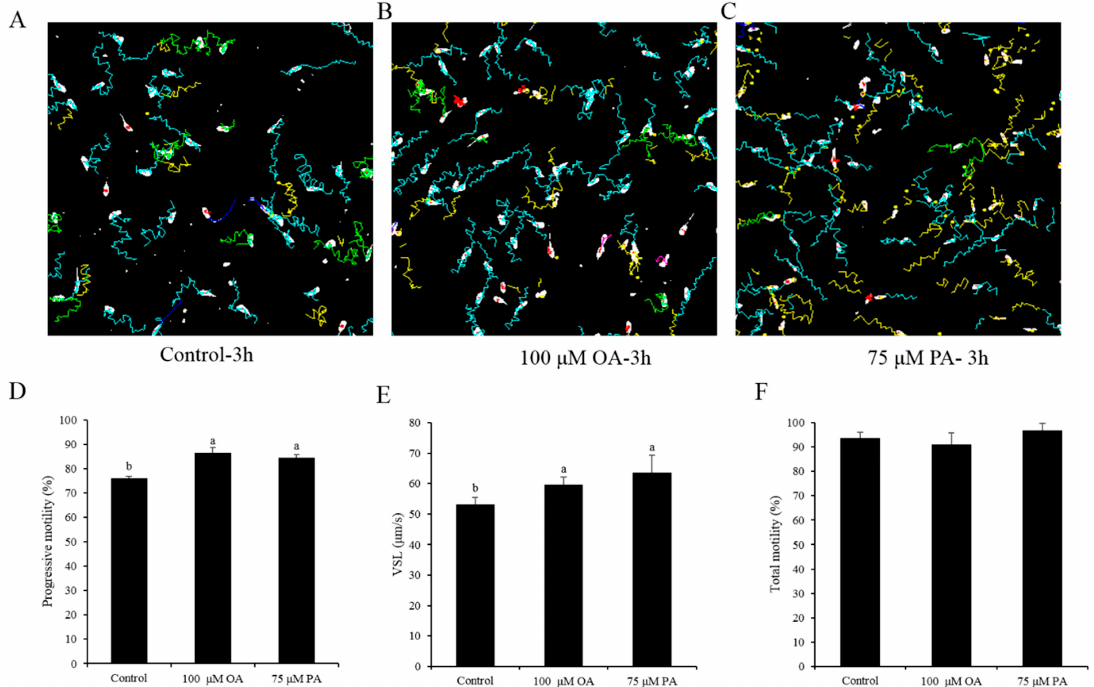
Figure 8. ( A – C ) Computer-assisted sperm motility analysis (CASA) derived changes in sperm motility track by the addition of OA and PA to the diluted medium. ( D – F ) Dynamic changes in the sperm parameters: ( D ) progressive motility, ( E ) VSL, and ( F ) total motility. Data are the mean ± standard deviation (SD). Columns with di ff erent lowercase letters di ff er significantly ( p <